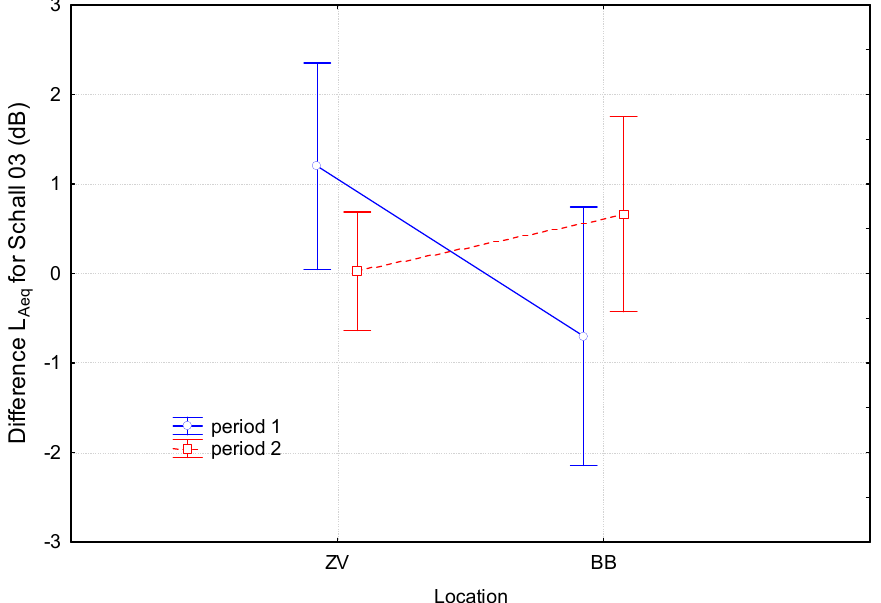
Figure 9. Graphical interpretation of the differences of the determining quantities obtained by Schall 03 and the measurement depending on the location and time of the measurement.